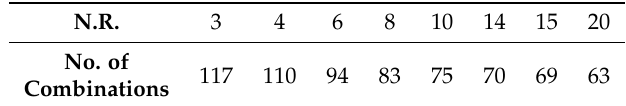
Table 1. Number of combinations analyzed as a function of N . R .